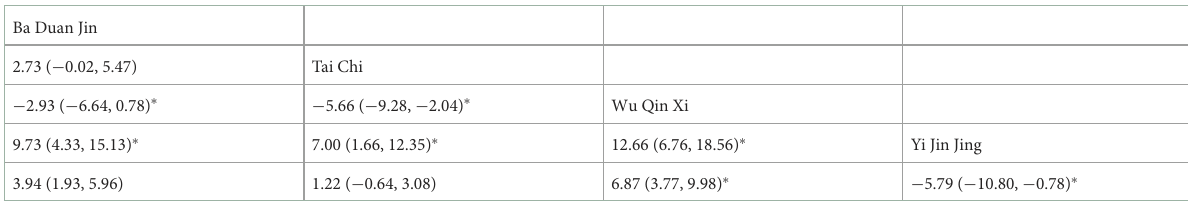
TABLE 3 Results of the network meta-analysis (SMD vs. 95% CI) of the effects of different traditional exercises on BBS in the